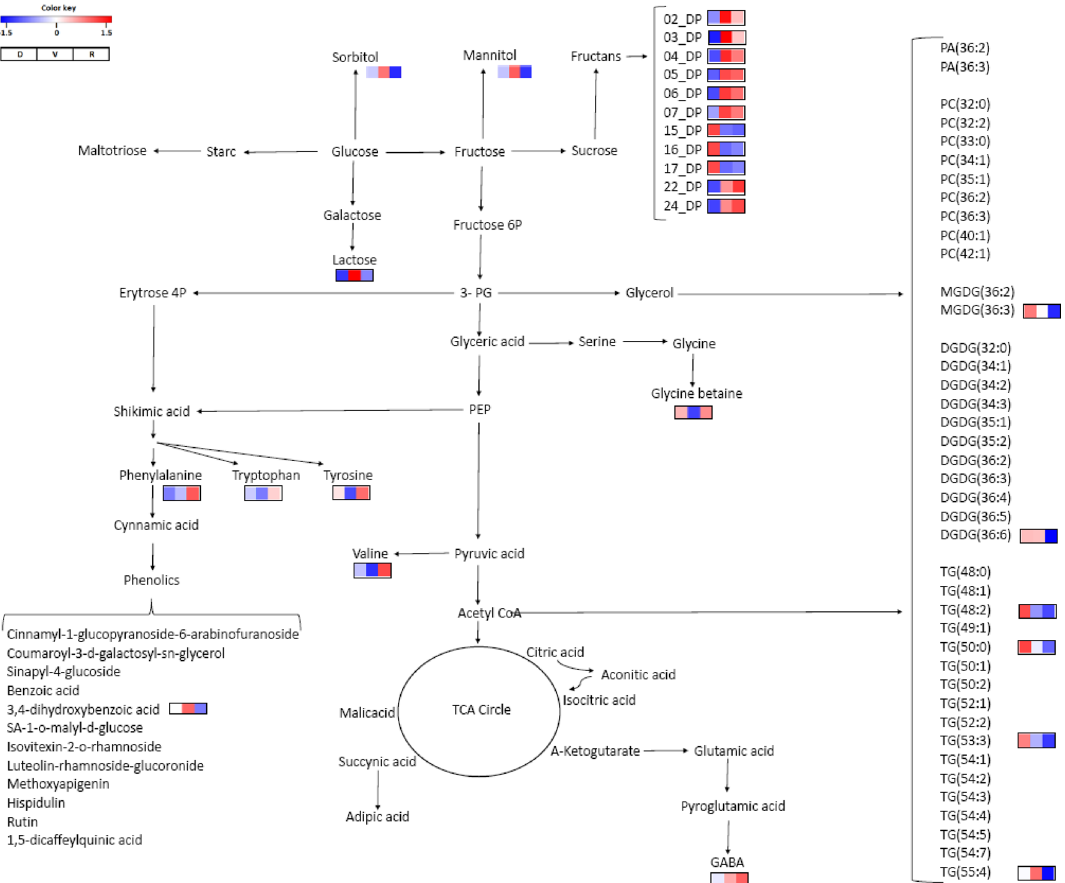
Figure 7. Metabolic pathway indicating the annotated metabolites of Gomphrena agrestis Mart. roots in a rock- field area in the dry and rainy seasons. Bars indicate relative intensity of metabolites, with pairwise